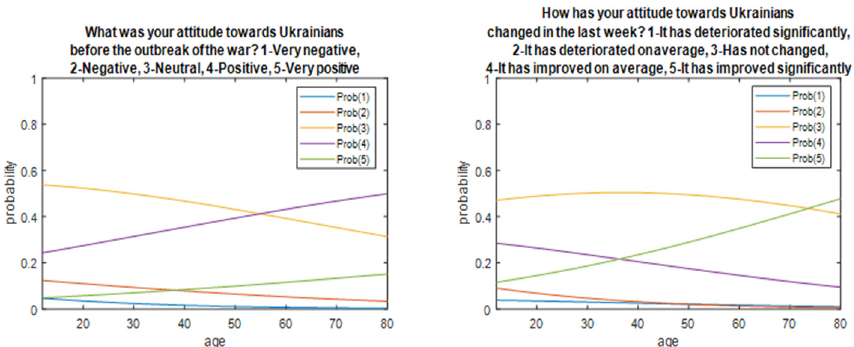
Figure 2. Probability distributions obtained from logistic regression concerning respondents’ answers depending on age.